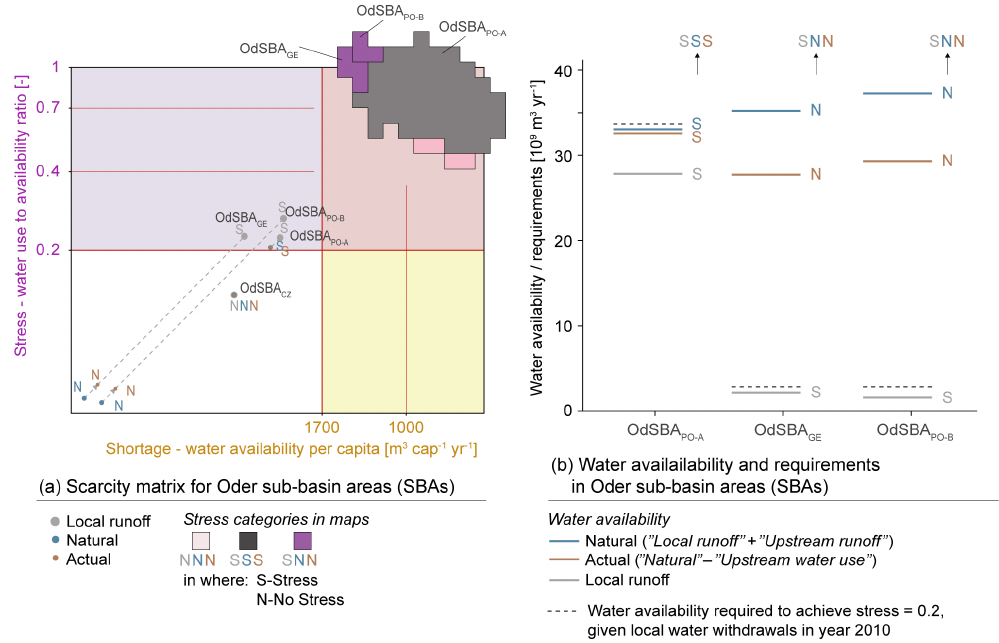
Figure 3. Scarcity and dependency category for the Oder sub-basin areas (SBAs) under annual average conditions. The Falkenmark ma- trix (a) and plot of water availability required to avoid stress (b) show changes in stress and shortage under different types of water avail- ability (see definitions in Table 1). The inset map represents the Oder SBAs corresponding dependency categories. Scarcity and dependency categories for each SBA for the year 2010 were calculated using a water stress threshold value of 0.2 and water shortage threshold value of 1000m 3 cap − 1 yr − 1 .